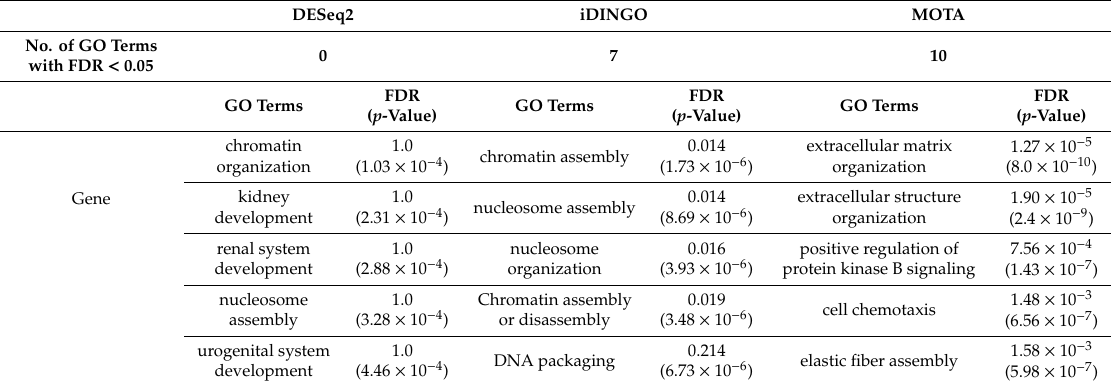
Table 4. Top-5 significant Gene Ontology (GO) terms based on genes selected by DESeq2, iDINGO, and MOTA. DESeq2 iDINGO MOTA No. of GO Terms with FDR <